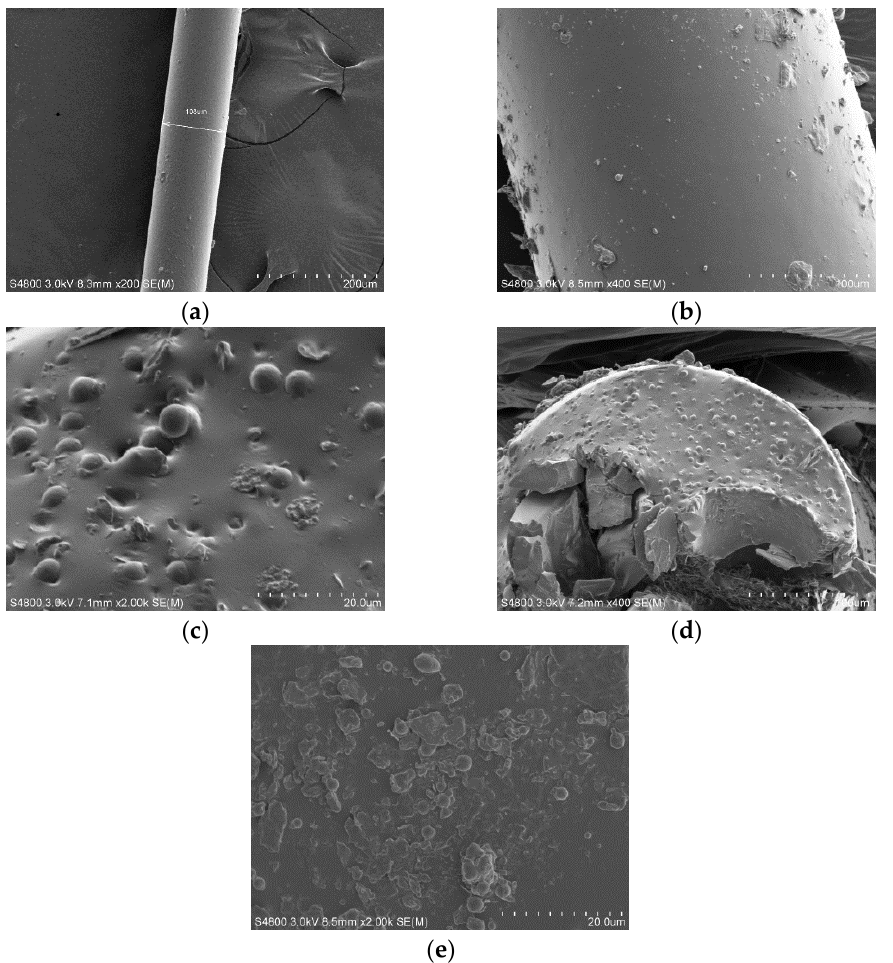
Figure 3. SEM micrographs of ( a ) bare fiber, ( b ) prepared fiber at 400×, ( c ) prepared fiber at 2000×, and cross-section of the prepared fiber at ( d ) 400× and ( e ) 2000×.